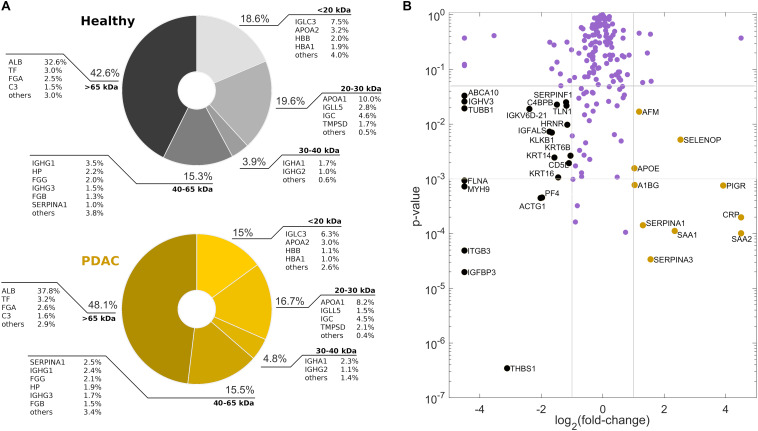
Protein corona composition by mass spectrometry experiments. (A) Pie charts and (B) volcano plot of the detected proteins in the corona of healthy donors and PDAC patients. Horizontal thresholds in (B) are set as p < 0.05 and p < 0.001, vertical thresholds are set at −1 and 1.